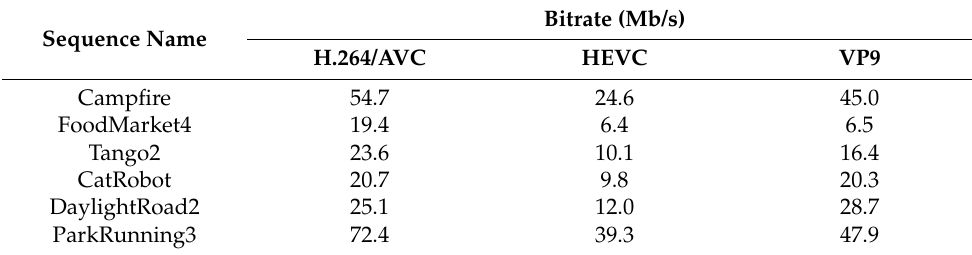
Table 4. Bitrates of the coded test bitstreams by H.264/AVC, HEVC and VP9 for test sequences.